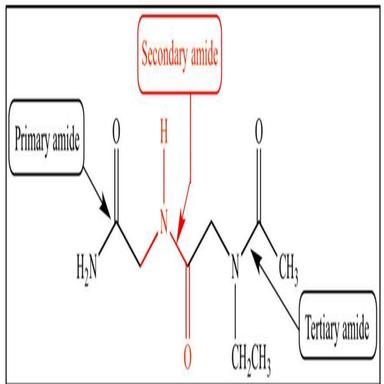
FTIR spectra of PVA/PANI/functionalized CNT nanocomposites film (a) with different gamma irradiation doses and (b) absorption bands at 3000–3600 cm-1.